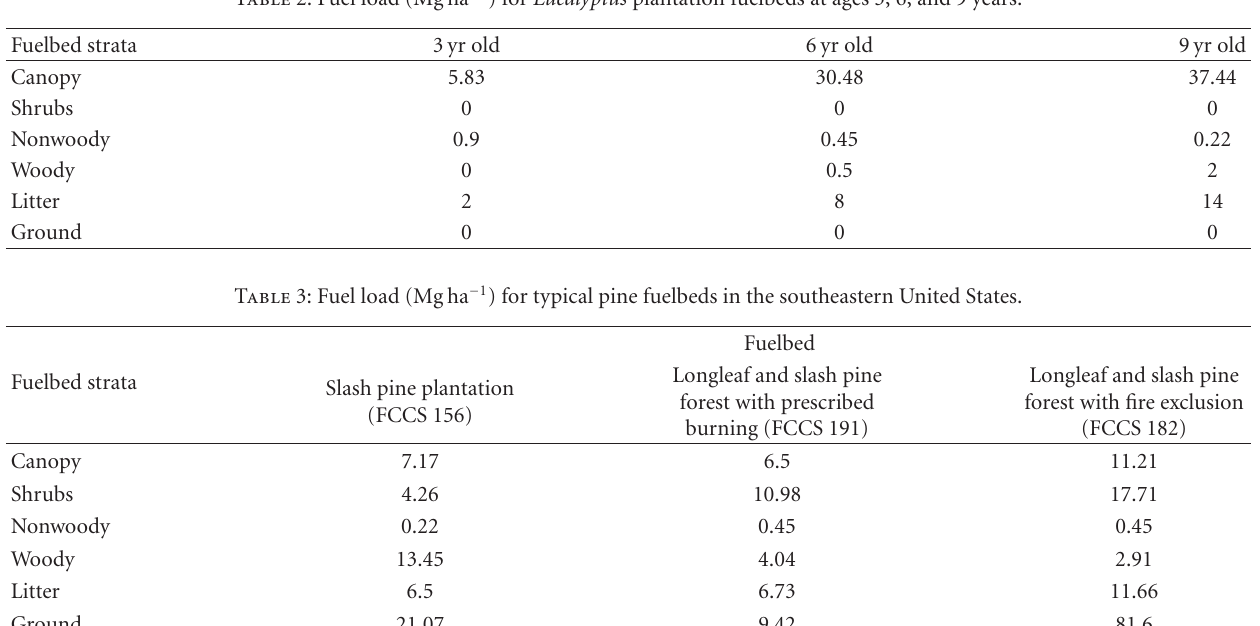
Table 2: Fuel load (Mgha − 1 ) for Eucalyptus plantation fuelbeds at ages 3, 6, and 9 years.